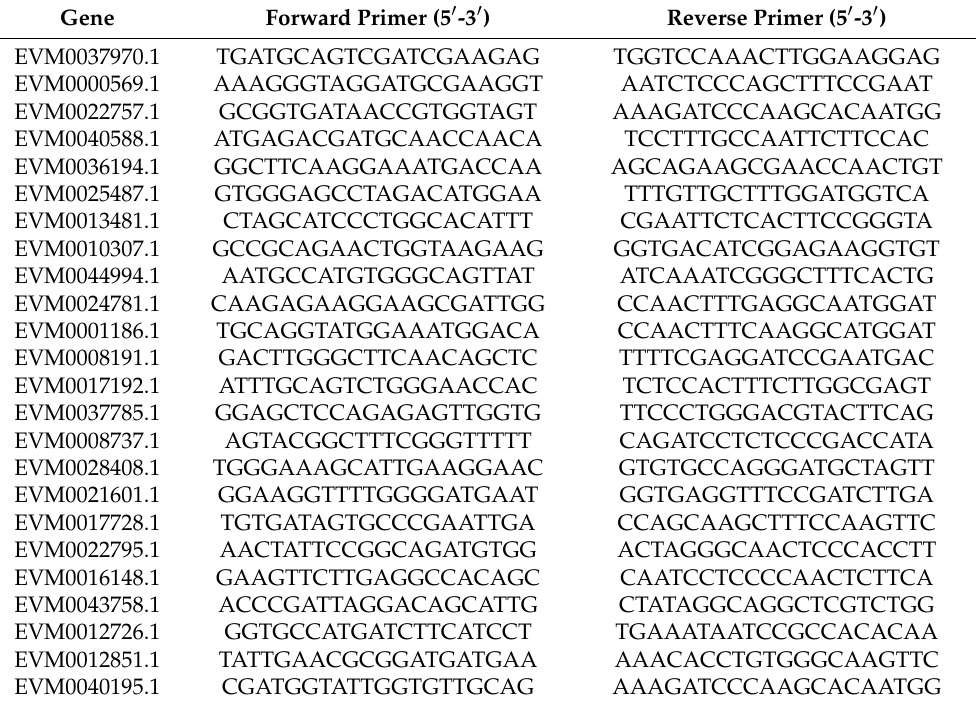
Table 1. Primer sequences of EjALMT genes.